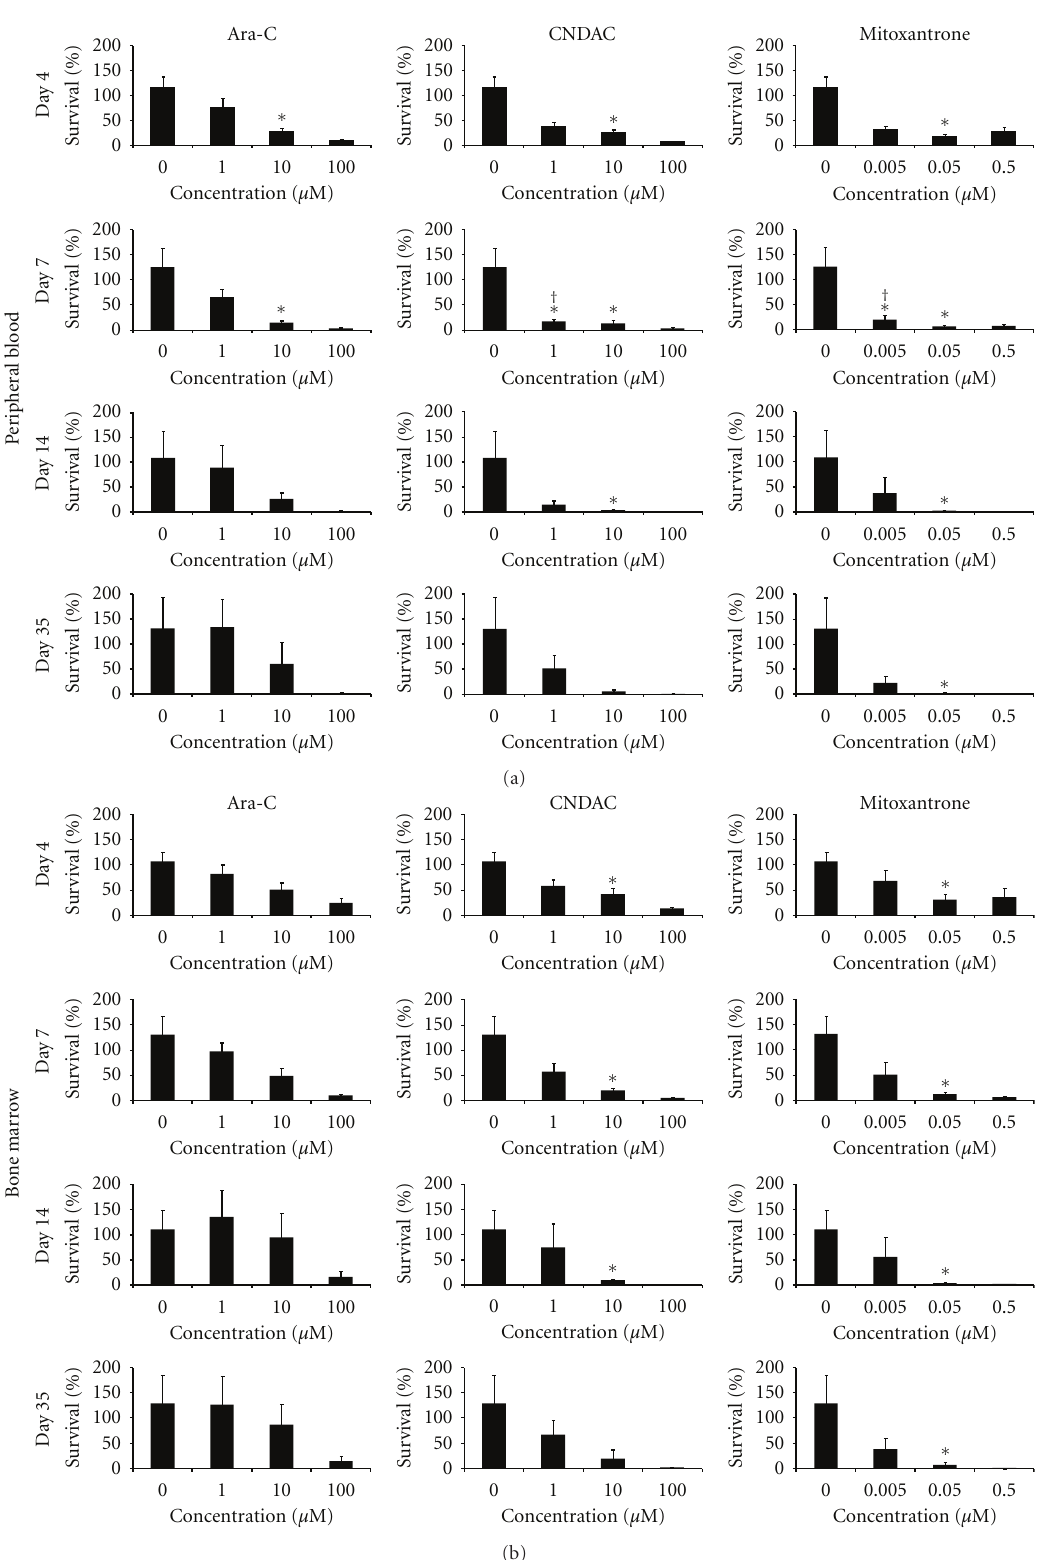
Figure 4: AML MNC ± drug treatment. Percentages survival (relative to number of cells plated) calculated from hemocytometer counts using trypan blue for (a) AML PB MNCs and (b) AML BM MNCs ( n = 5 patients) treated with ara-C, CNDAC or mitoxantrone are shown. PB MNCs were drug-treated in suspension, while BM MNCs were treated in the presence of M2-10B4 stromal layers for 4 days (Day 4). Cells were then washed and replated on M2-10B4 stromal layers for post-drug wash-out analysis on days 7, 14, and 35. ∗ denotes P ≤ 0.05 for particular drug concentrations compared with untreated, and † denotes P ≤ 0.05 for 1 μ M CNDAC or 0.005 μ M mitoxantrone compared to 1 μ M